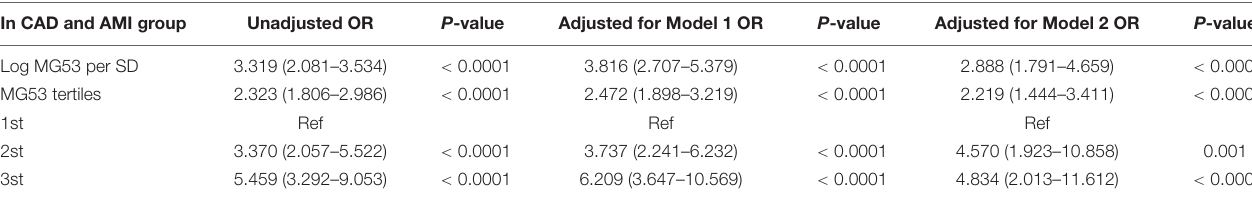
TABLE 3 | Associations of serum MG53 with the presence of